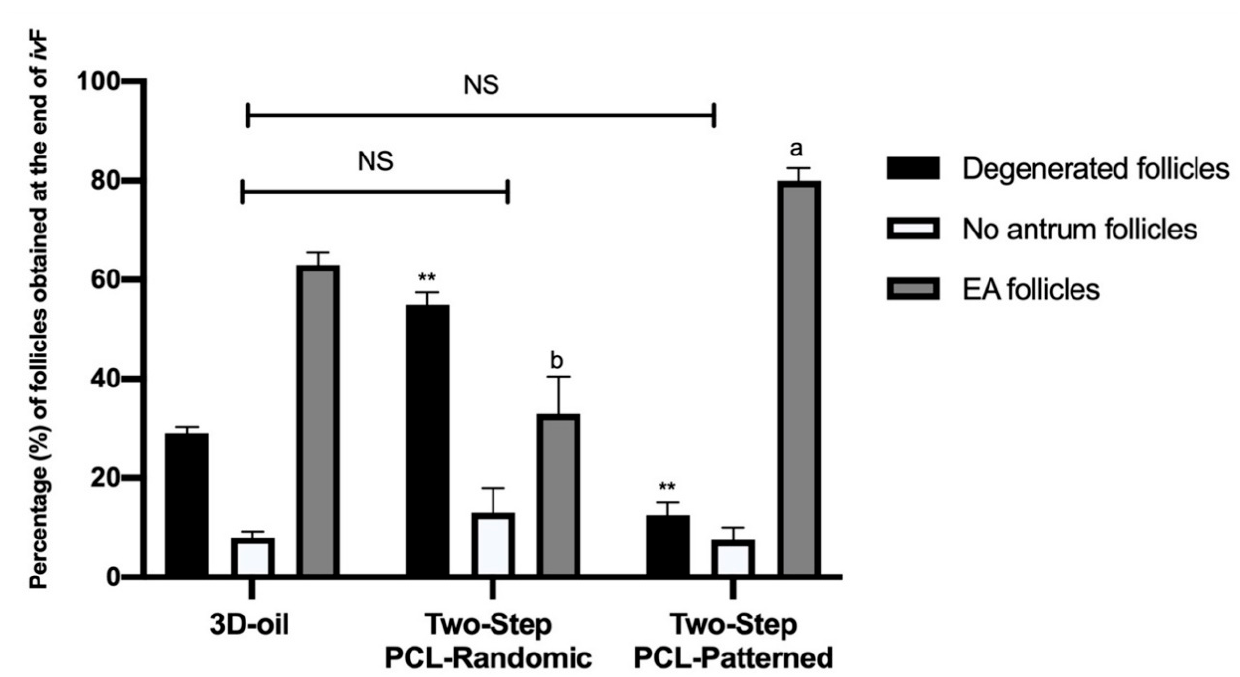
Figure 3. SEM analysis of the PCL-Patterned (A) and PCL-Randomic (B) scaffolds. PCL-Patterned scaffold is reported in A and its zoomed view is shown in a green frame. The scale bars are 100 μ m (magnification 100×) and 20 μ m (magnification 500×), respectively. The PCL-Randomic is reported in the bottom ( B ) (magnification 500×) and a higher magnification (10 k× image is shown in a yellow frame. For those images the scale bars are 10 μ m and 1 μ m, respectively.